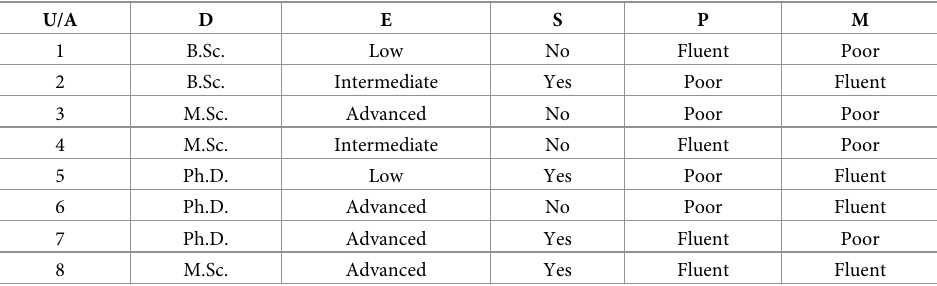
Table 8. Student’s enrollment qualification information